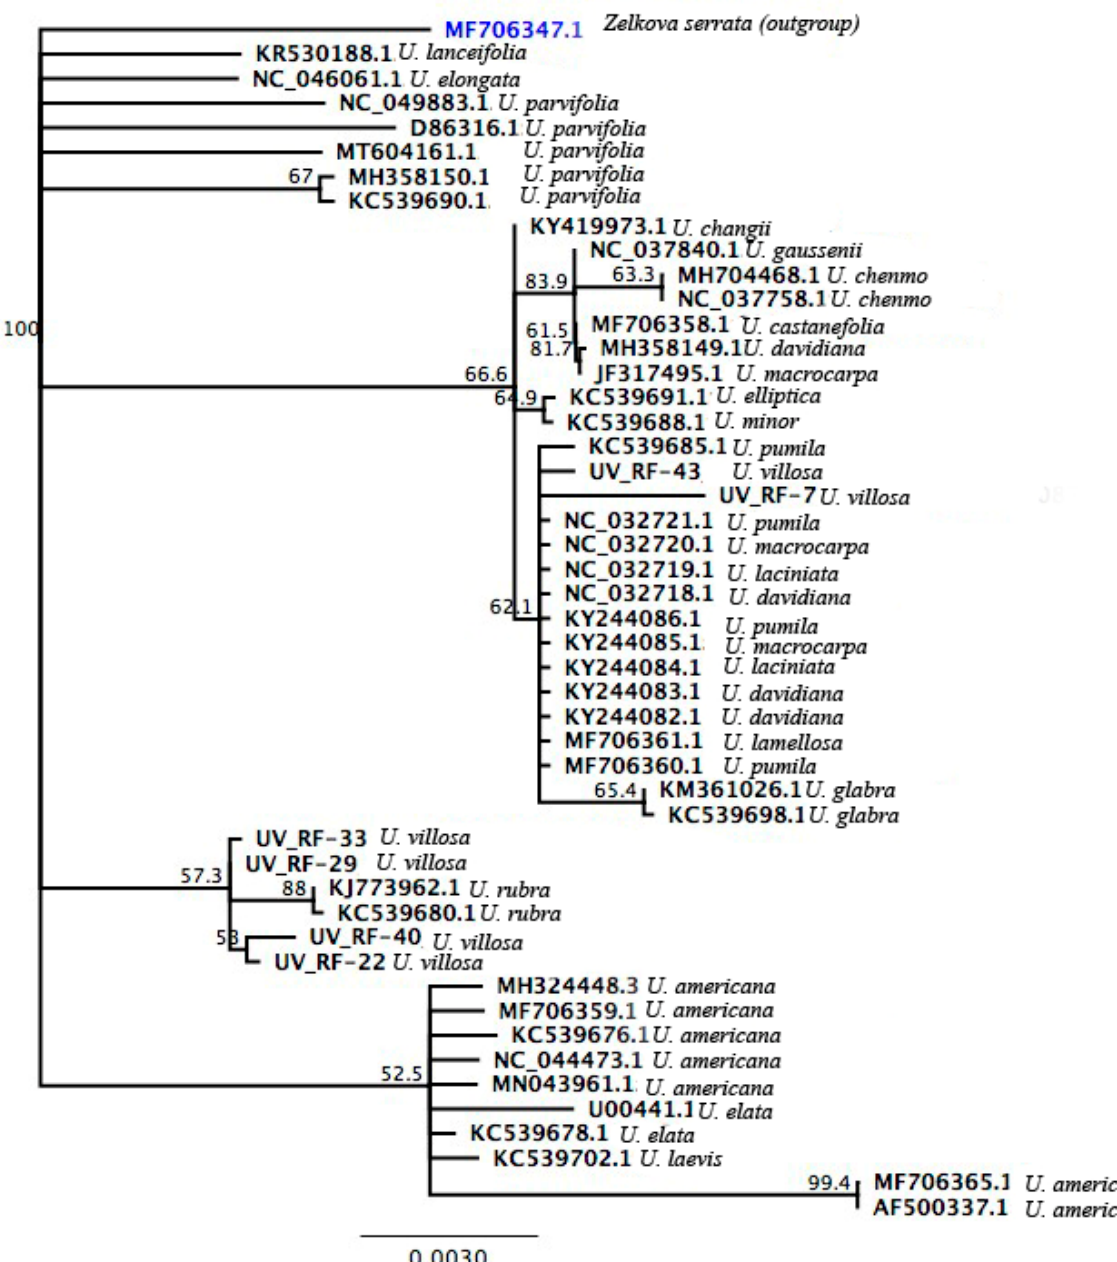
Figure 6. Neighbor joining (NJ) tree based on rbc L region. The bootstrap consensus tree was inferred from 1000 replicates.